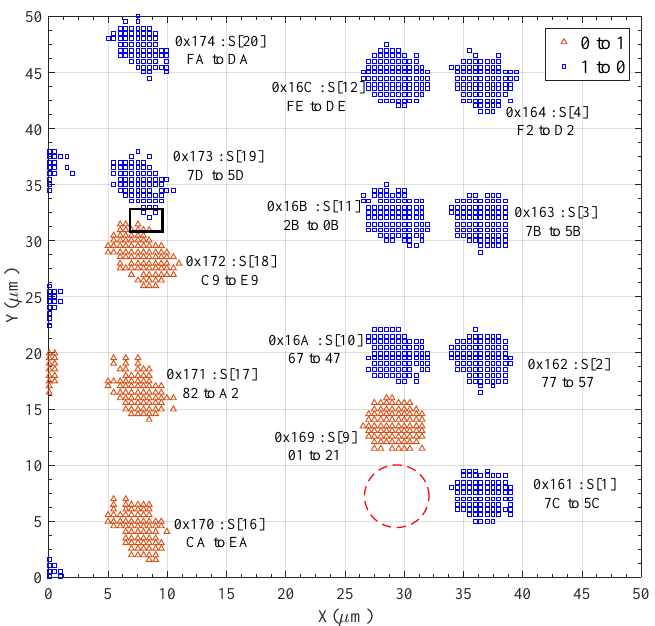
Figure 12: Distribution of the sensitive region in 50 µm × 50 µm